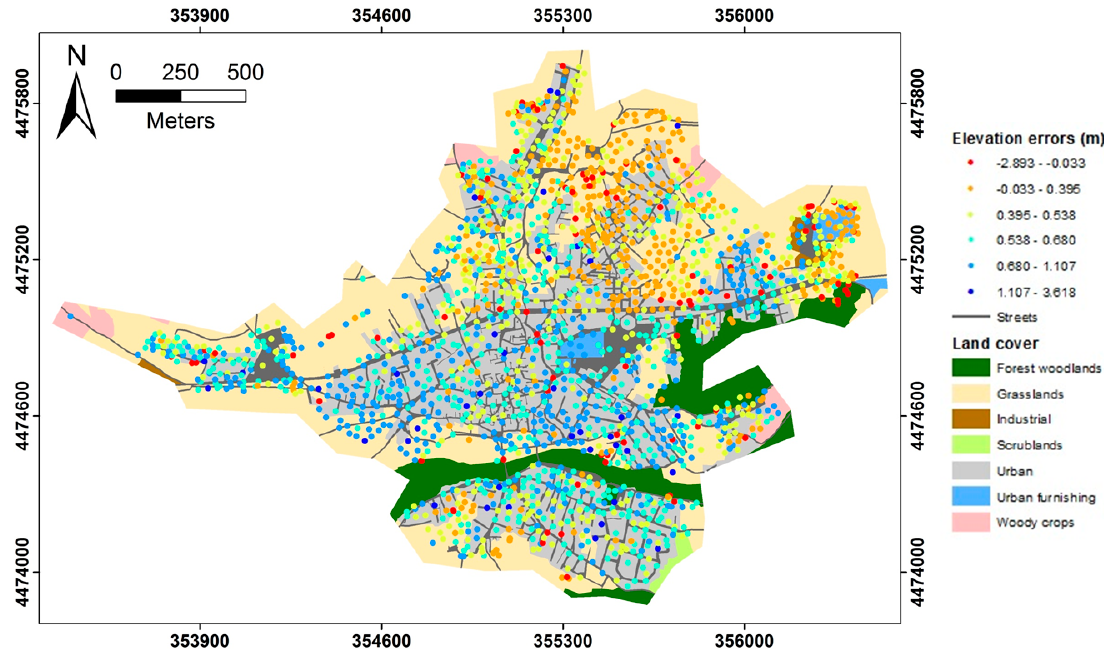
Figure 9. Classified land cover map with overlaid elevation errors for the 1987 field measurements provided by the Spanish cadastre.